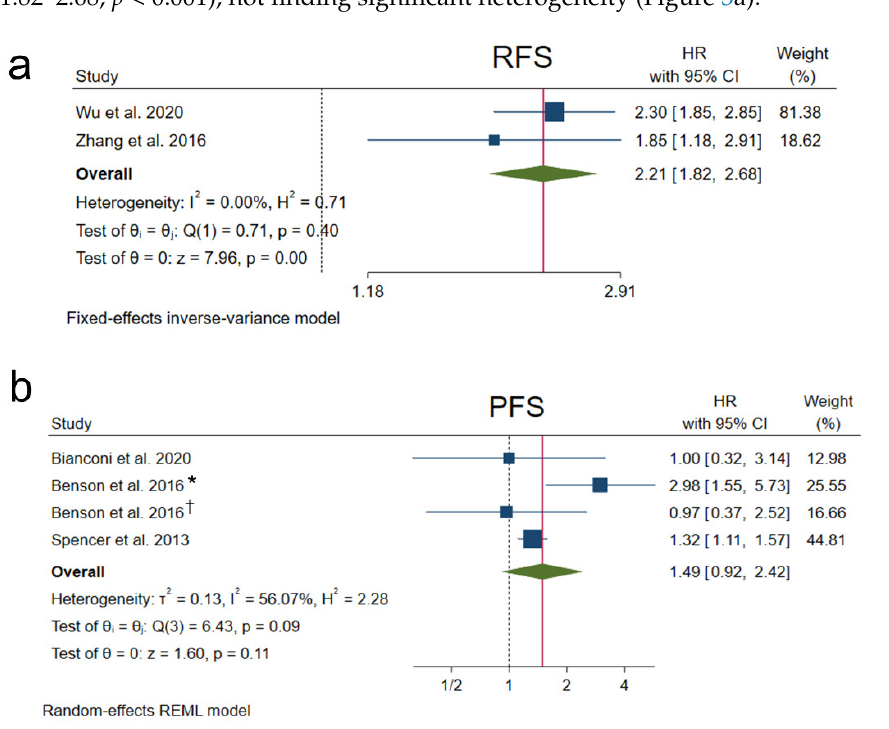
Figure 3. Forest plots showing HR for studies assessing the association of NRP1 overexpression and ( a ) RFS or ( b ) PFS. CI, confidence interval; HR, hazard ratio; PFS, progression-free survival; REML, Restricted Maximum Likelihood; RFS, recurrence-free survival. [22,23,25,26,28] * Tivozanib/mFOLFOX6 group, † bevacizumab/mFOLFOX6 group.